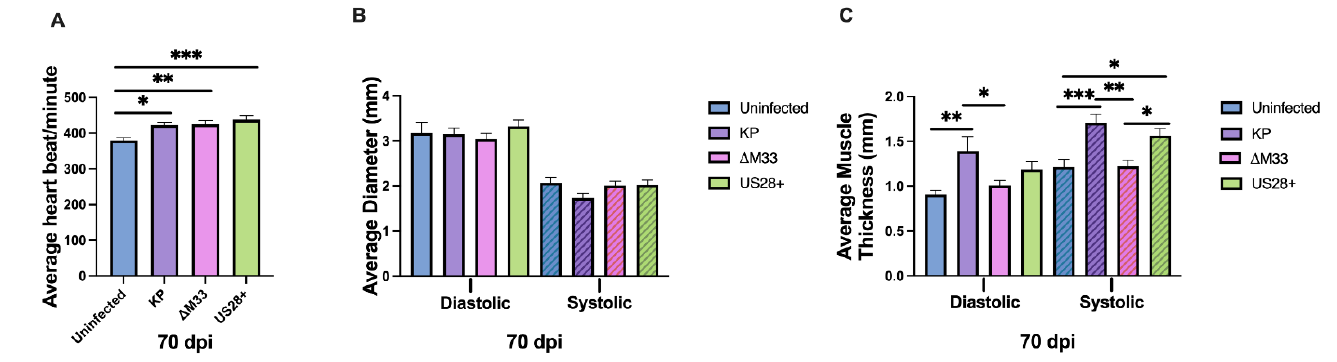
Figure 5. MCMV-induced cardiac dysfunction at 70 dpi. Mice were uninfected or infected with 1 × 10 6 PFU i.p. At 70 dpi, echocardiography was conducted: ( A ) average heart rate per group, ( B ) average left ventricular diameter, and ( C ) average left ventricular posterior wall thickness were analyzed. Group mean and standard error of the mean were calculated. Significance was determined by ANOVA and Tukey’s multiple comparisons test. * p < 0.05, ** p < 0.005, *** p < 0.0005. Studies were conducted in triplicate ( n =